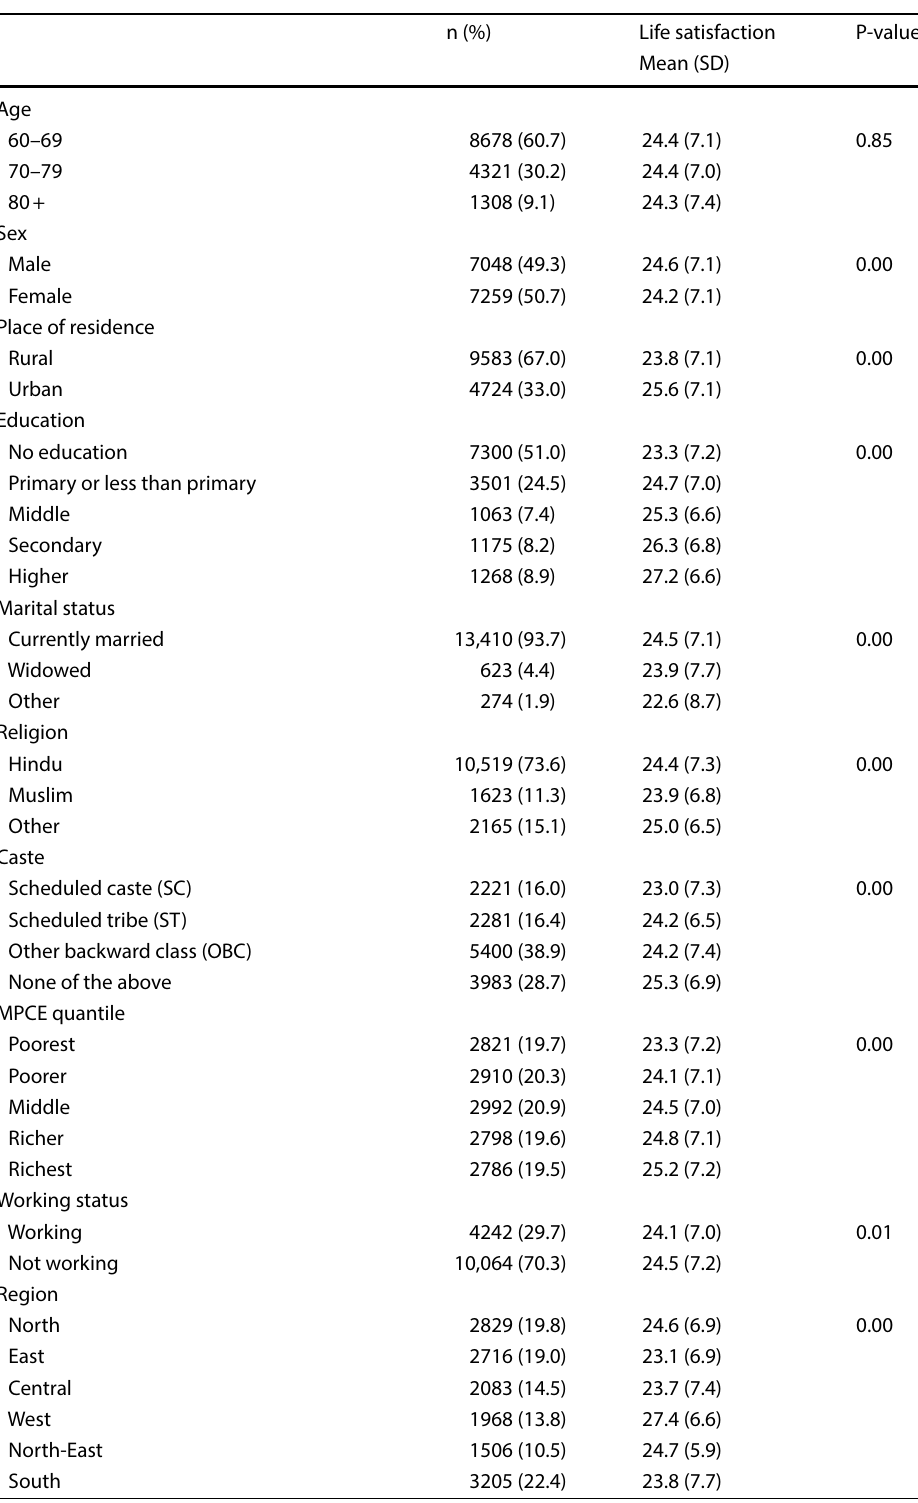
Table 1 Background characteristics of the study participants and mean life satisfaction level in various background